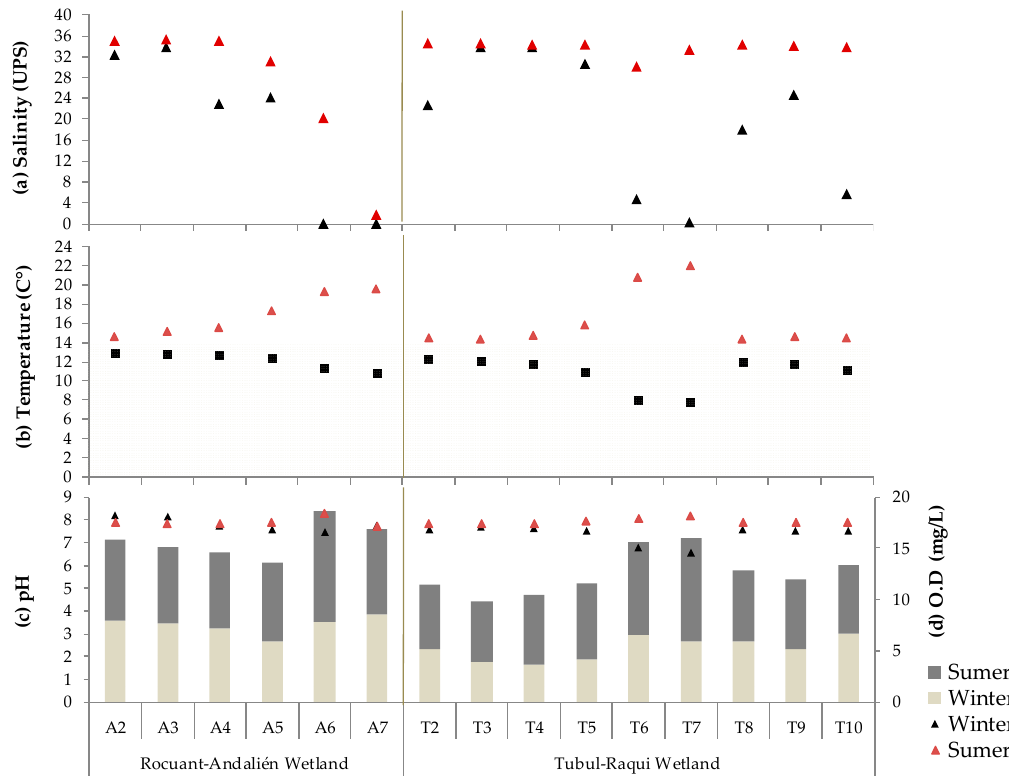
Figure 2 . Parameters of ( a ) Salinity, ( b ) Temperature, ( c ) pH, and ( d ) DO at the observed stations in the Rocuant-Andalíen and Tubul-Raqui wetlands, in summer and winter.